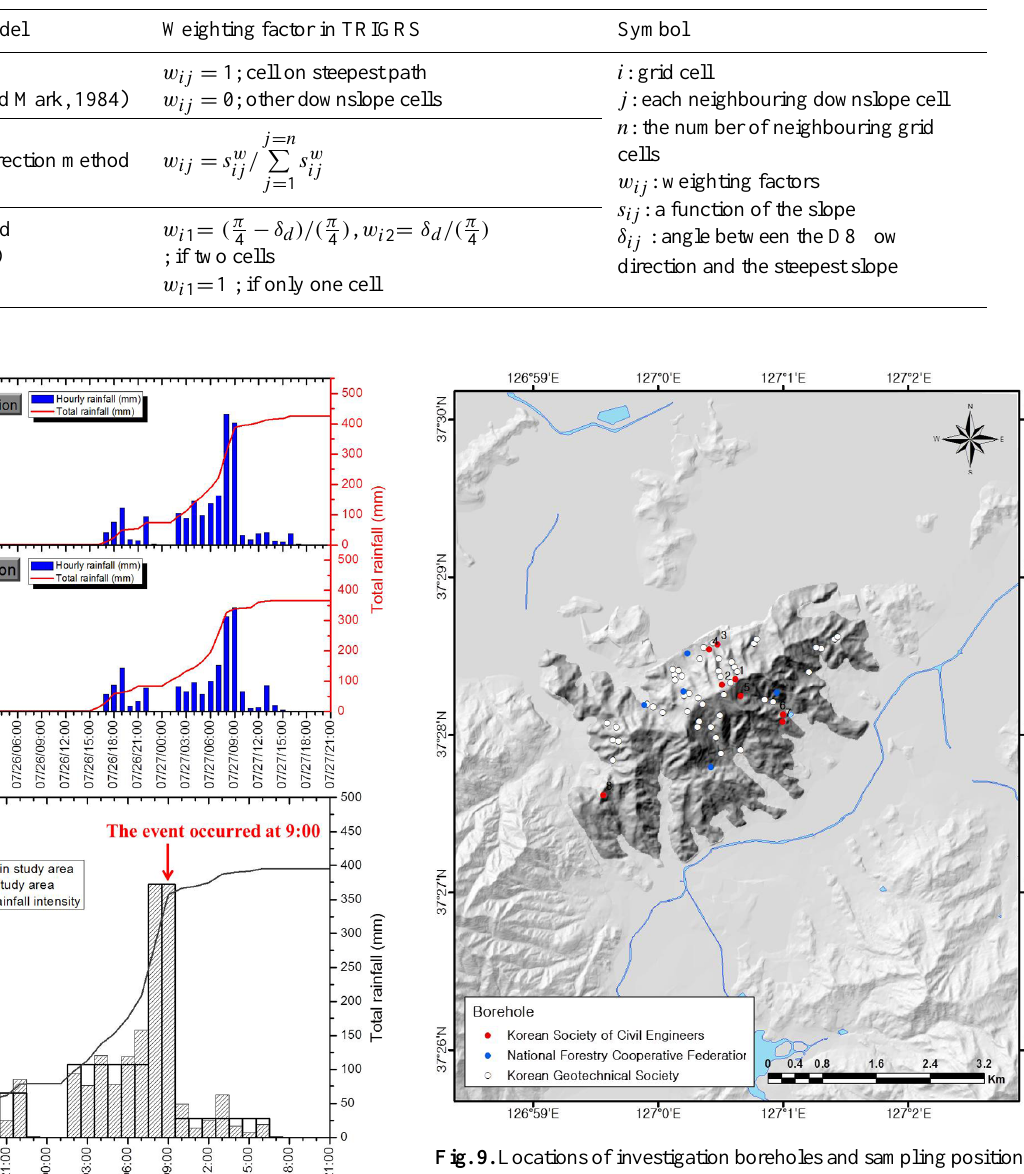
Table 1. Summary of flow routing models.